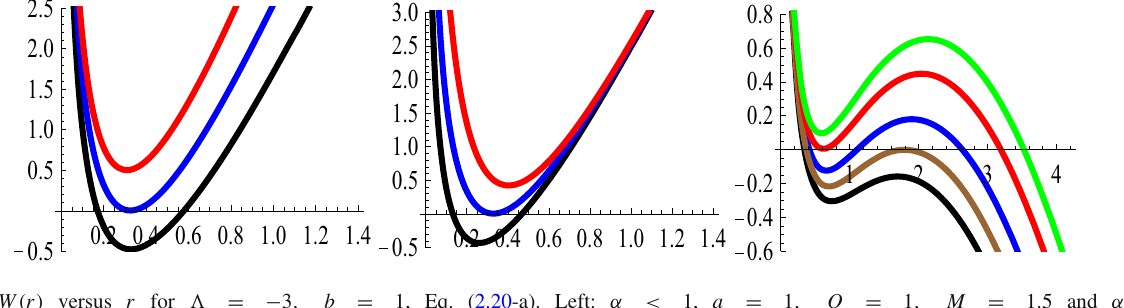
Fig. 1 W ( r ) versus r for (cid:11) = − 3 , b = 1, Eq. (2.20-a). Left: α < 1, a = 1 , Q = 1 , M = 1 . 5 and α = 0 . 63 ( black ), 0 . 702 ( blue ), 0 . 76 ( red ). Middle: α < 1, α = 0 . 7 , Q = 1 , M = 1 . 5 and a = 0 . 8 ( black ), 1 . 01 ( blue ), 1 . 4 ( red ) .